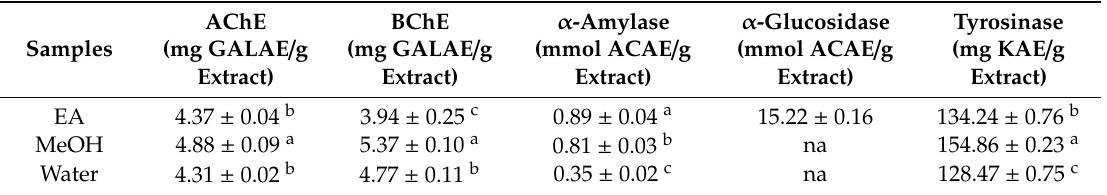
Table 3. Enzyme inhibitory properties of the tested